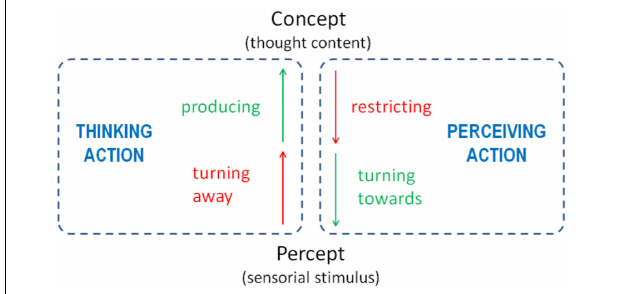
FIGURE 5 | Complementary structure of perceiving and thinking. In the structure-phenomenological inquiry of a perceptual reversal four micro-gestures of mental action can be distinguished. They can be generalized as forms of mentally separating (turning away, restricting) and integrating (producing, turning